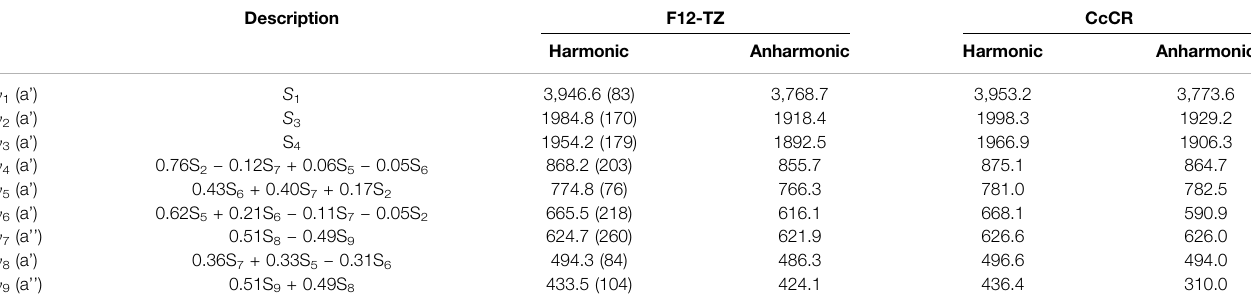
TABLE 3 | Vibrational Frequencies (in cm − 1 ) of AlH 2 OH with MP2/aug-cc-pVTZ Intensities in Parentheses (in km/mol).